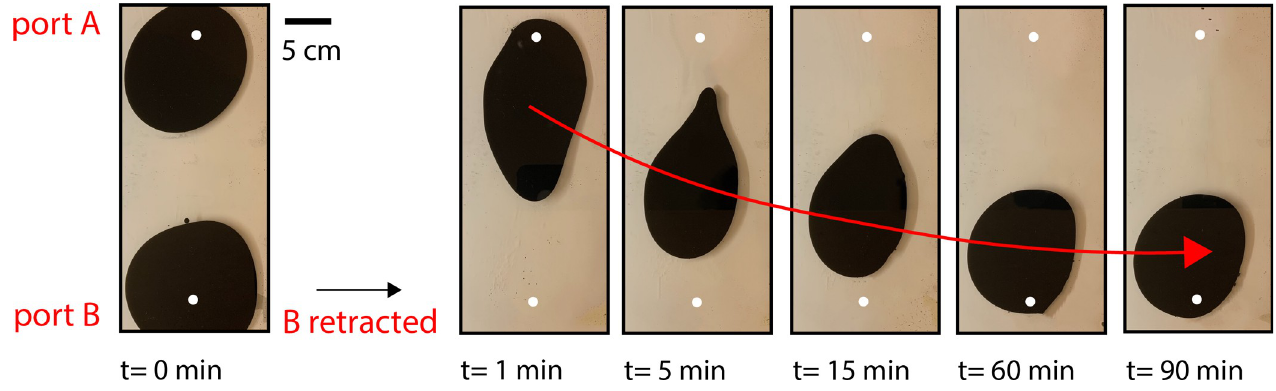
Fig 7. Multiport time-dependent droplet migration due to a hydrodynamic potential.